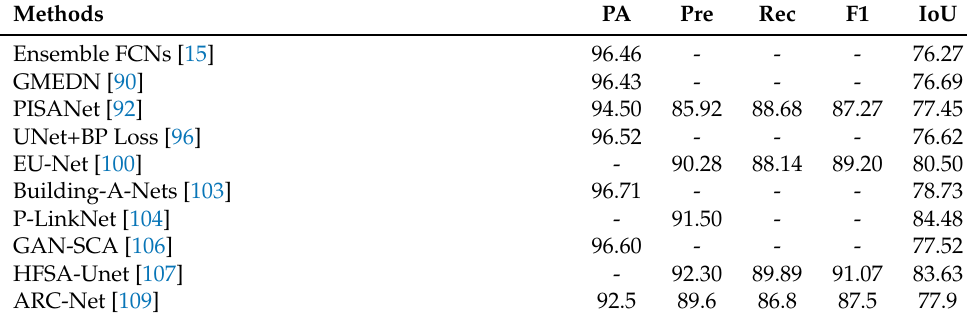
Table 3. Results on Inria building dataset (%).